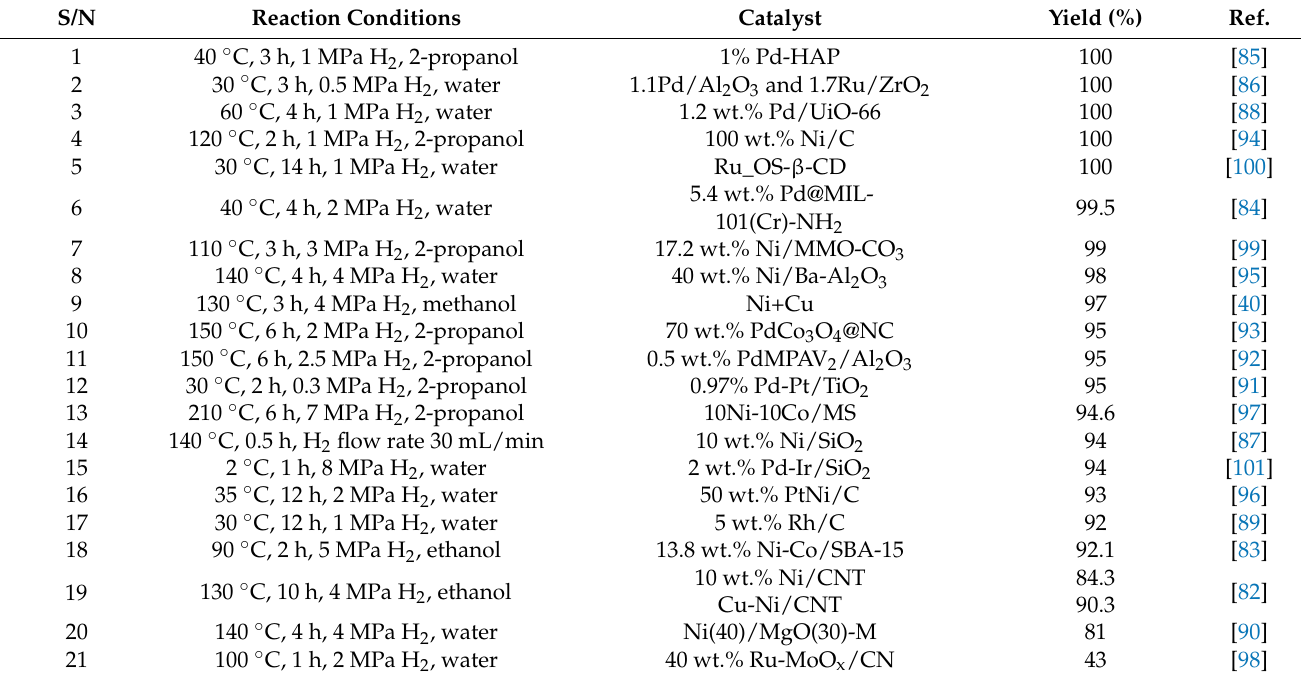
Table 2. The catalytic preparation of THFAL from